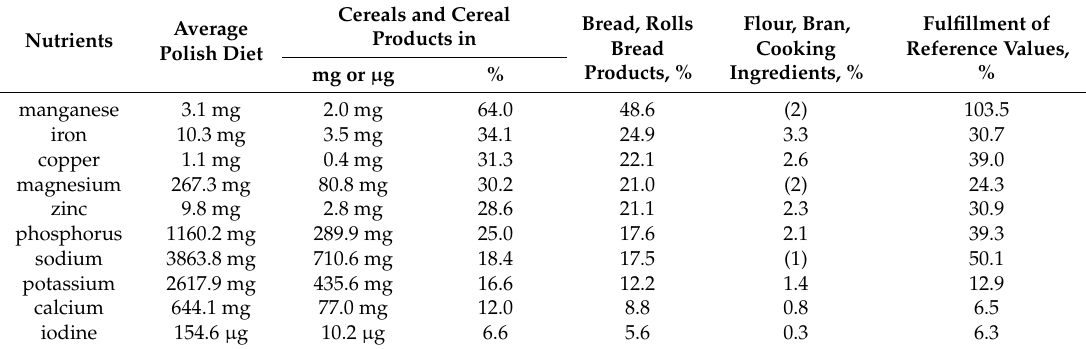
Table 5. Minerals: contribution by cereals and cereal products to the average Polish diet, top two main groups and fulfillment of the reference